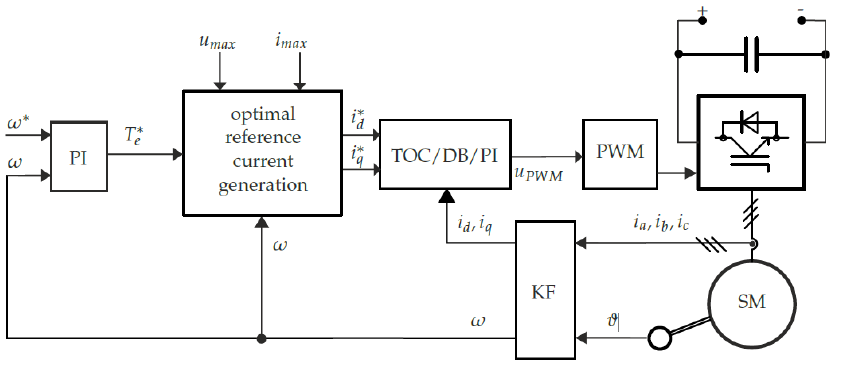
Figure 5. Block diagram of the tested closed loop